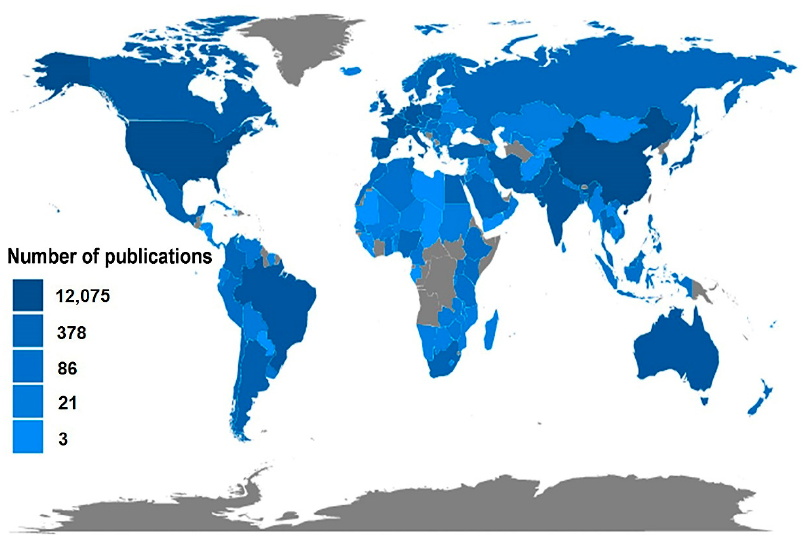
Figure 6. The distribution map of the number of publications of countries between 2000 and 2021 .